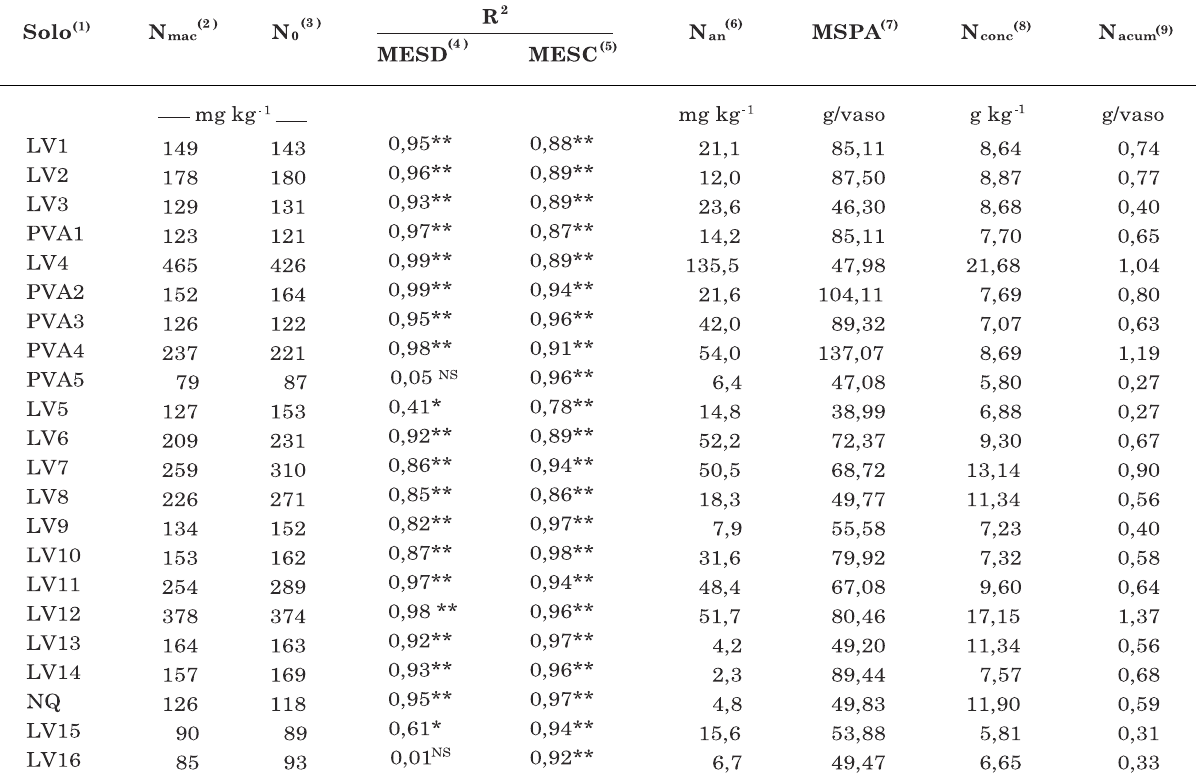
estimativa de N potencialmente mineralizável, coeficientes de determinação dos modelos